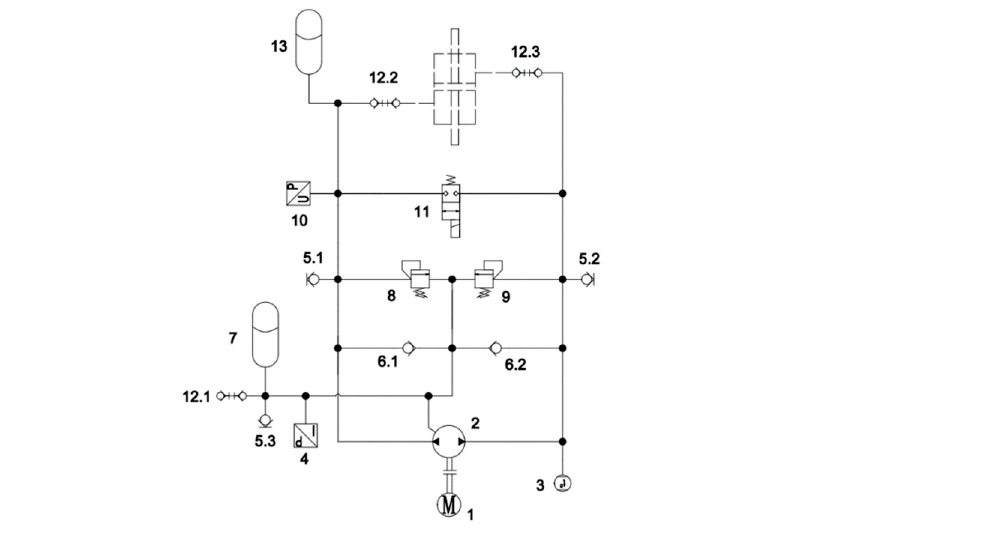
Figure 1. Electro-hydrostatic actuator (EHA) hydraulic schematic: 1—servo motor; 2—fixed dis- placement two-way hydraulic pump; 3—temperature sensor; 4—pressure relay; 5—pressure joint; 6—one-way valve; 7—fill oil accumulator; 8—high-pressure relief valve; 9—low-pressure relief valve; 10—pressure sensor; 11—unloading valve; 12—quick release coupling; and 13—pressure pulsation absorber accumulator.